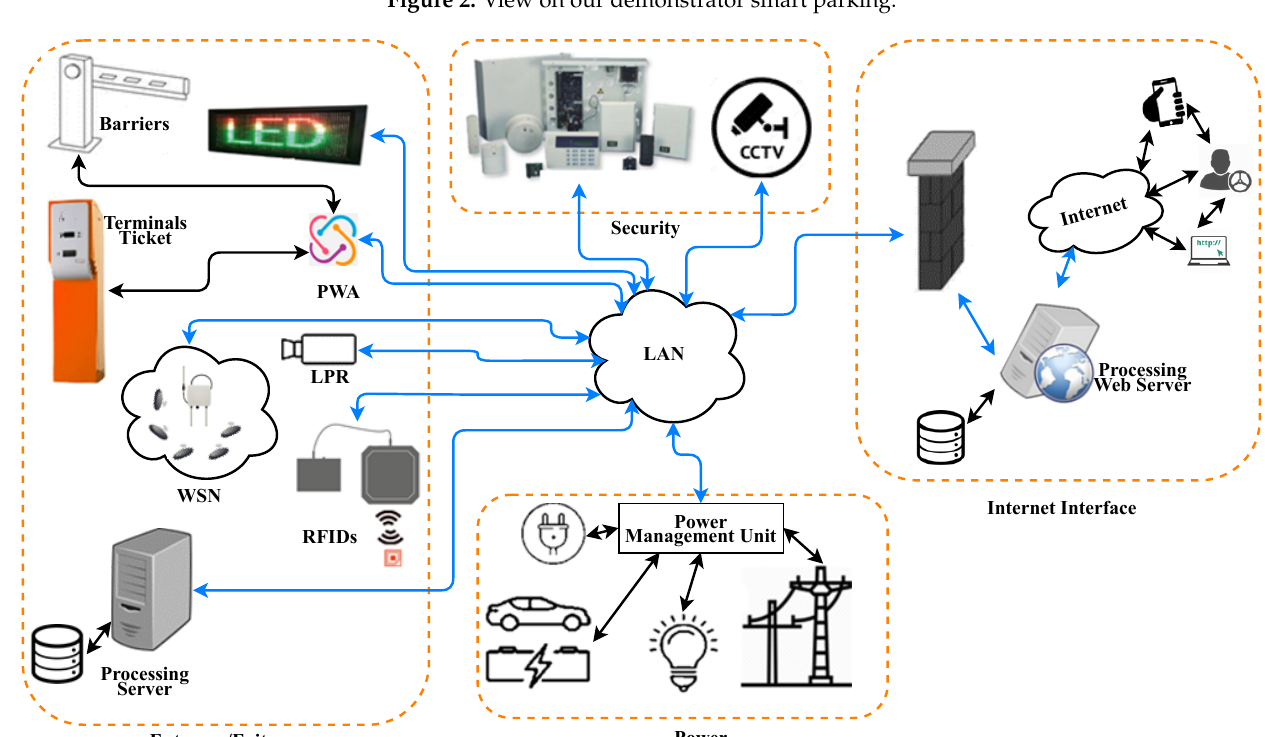
Figure 2. View on our demonstrator smart parking.